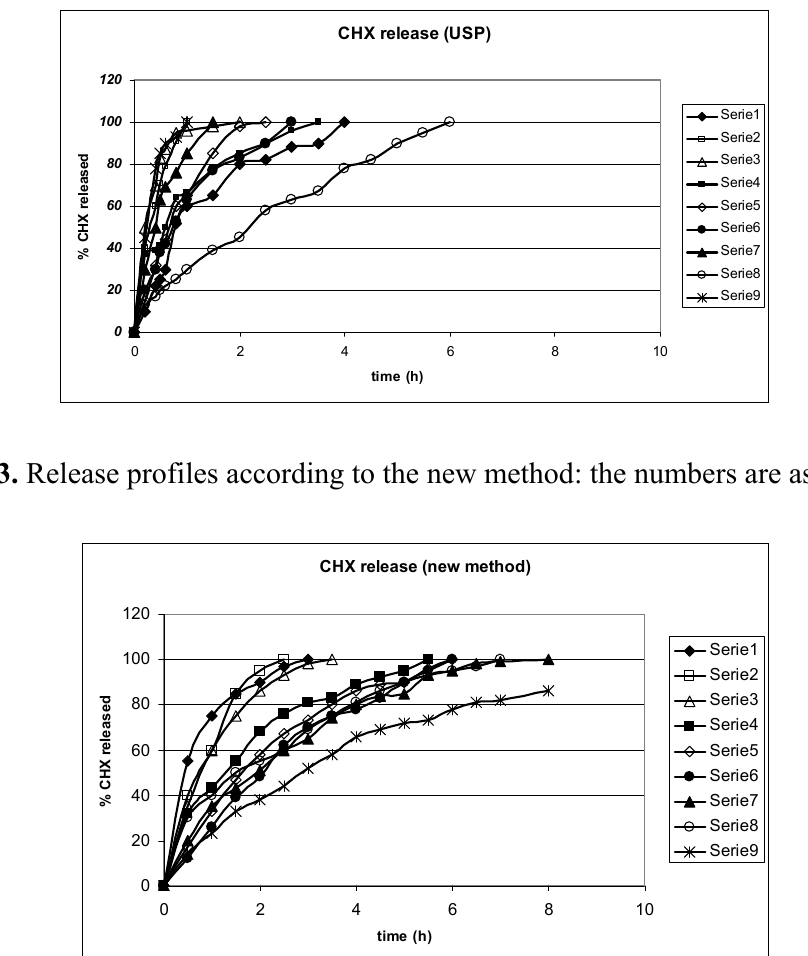
Figure 2. Release profiles according to the USP method. The numbers are as in Table 1.